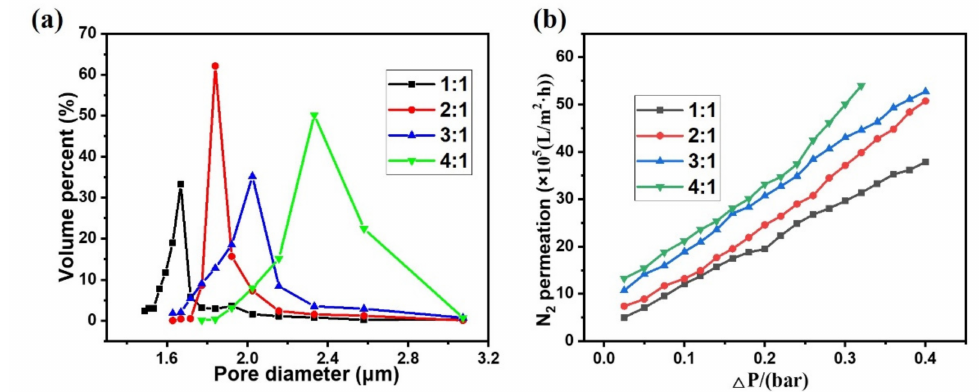
Figure 4. Pore size distribution ( a ) and N 2 permeability ( b ) of sintered samples with oil–water volume ratios of 1:1, 2:1, 3:1, and